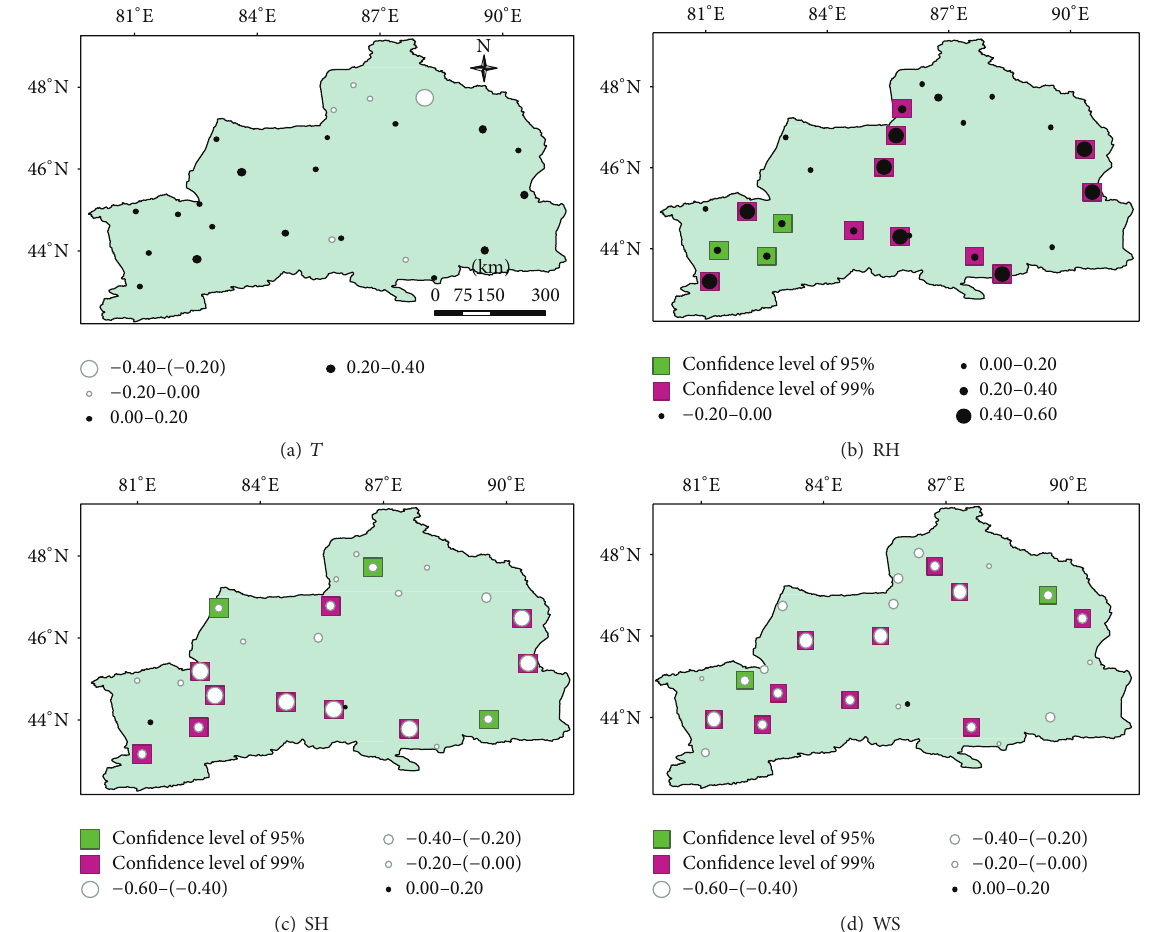
Figure 5: Spatial distribution of temporal correlations of time series AI with temperature ( 𝑇 ), relative humidity (RH), wind speed (WS), and sunshine hours (SH) in North Xinjiang,